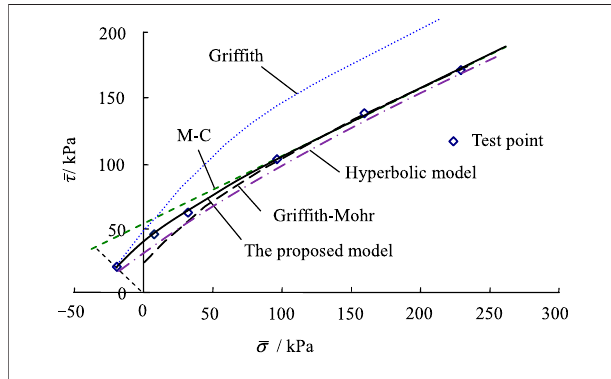
FIGURE 10 | Predictions by different strength models for dam clay.